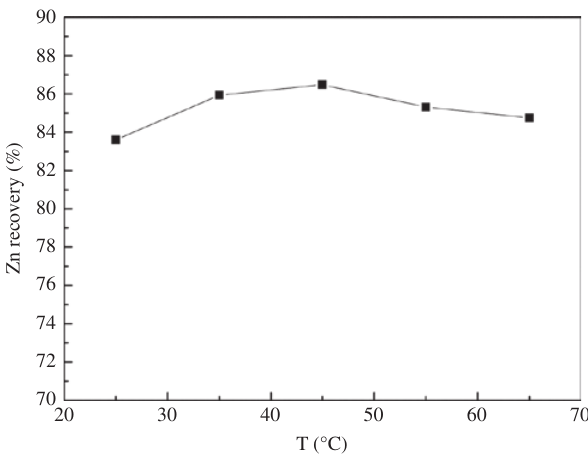
Figure 10: Effect of different leaching temperatures on leaching rate of